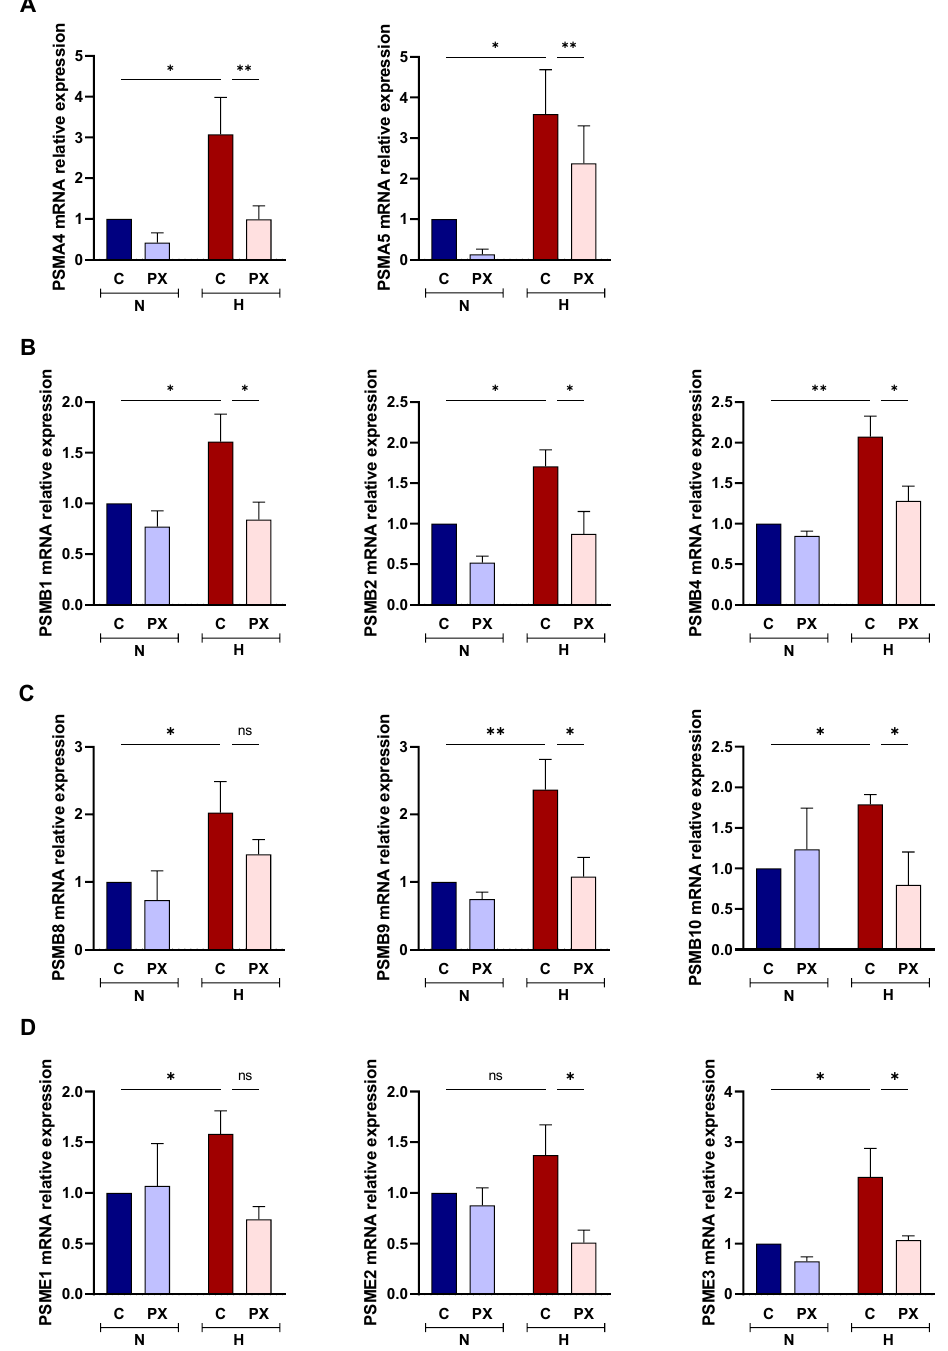
Figure 3. In vitro model of the effect of hypoxia on proteasome subunits expression. mRNA ex- pression of proteasome subunits from healthy volunteers PBMCs ( n = 5) cultured in normoxia (N) or hypoxia (H) and treated with PX478 (PX) or untreated (C). ( A ) 20S proteasome alpha ring subunits: PSMA4, PSMA5; ( B ) 20S proteasome beta ring non-catalytic subunits: PSMB1, PSMB2, PSMB4; ( C ) 20S immunoproteasome beta ring catalytic subunits: PSMB8, PSMB9, PSMB10; and ( D ) 11S proteasome subunits: PSME1, PSME2, PSME3. Mean differences were analysed using mixed- effects analysis with Bonferroni’s multiple comparison test. Error bars: standard error of the mean. *: p < 0.05, **: p <